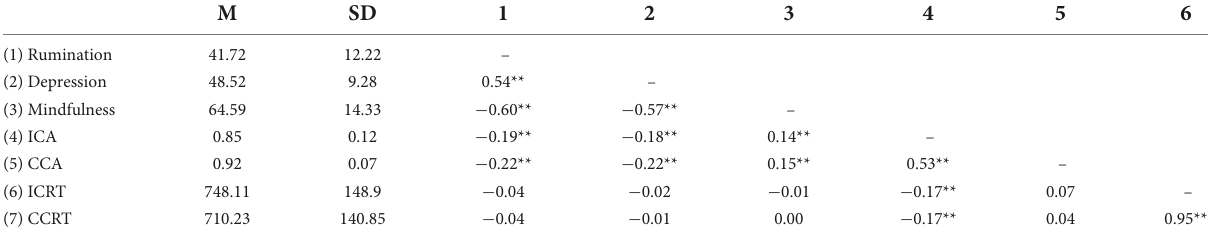
TABLE 2 Means, standard deviations, and correlations of the main variables.